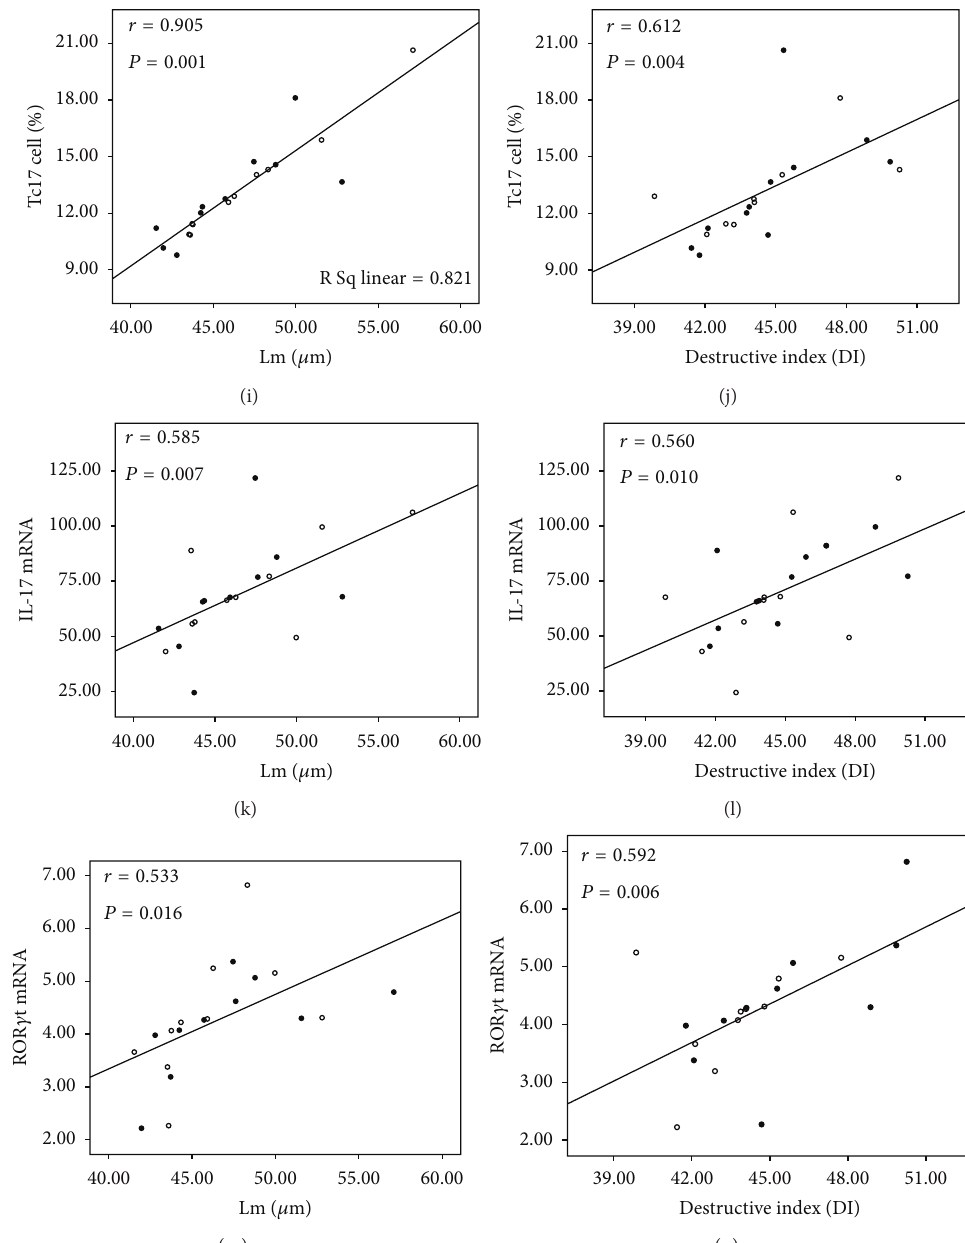
Figure 5: Correlations between (a) the protein levels of IL-8 in BALF and Lm, (b) the protein levels of IL-8 in BALF and DI, (c) the protein levels of TNF- 𝛼 in BALF and Lm, (d) the protein levels of TNF- 𝛼 in BALF and DI, (e) the protein levels of IFN- 𝛾 in BALF and Lm, (f) the protein levels of IFN- 𝛾 in BALF and DI, (g) the frequency of CD 4 + IL- 17 + Th17 cells in lungs and Lm, (h) the frequency of CD 4 + IL- 17 + Th17 cells in lungs and DI, (i) the frequency of CD 8 + IL- 17 + Tc17 cells in lungs and Lm, (j) the frequency of CD 8 + IL- 17 + Tc17 cells in lungs and DI, (k) the levels of IL-17 mRNA in lungs and Lm, (l) the levels of IL-17 mRNA in lungs and DI, (m) the levels of ROR 𝛾 t mRNA in lungs and Lm, and (n) the levels of ROR 𝛾 t mRNA in lungs and DI. Data were determined by Pearson’s rank correlation coeficients. Smoke-exposed mice (open circle) smoke cessation mice (closed